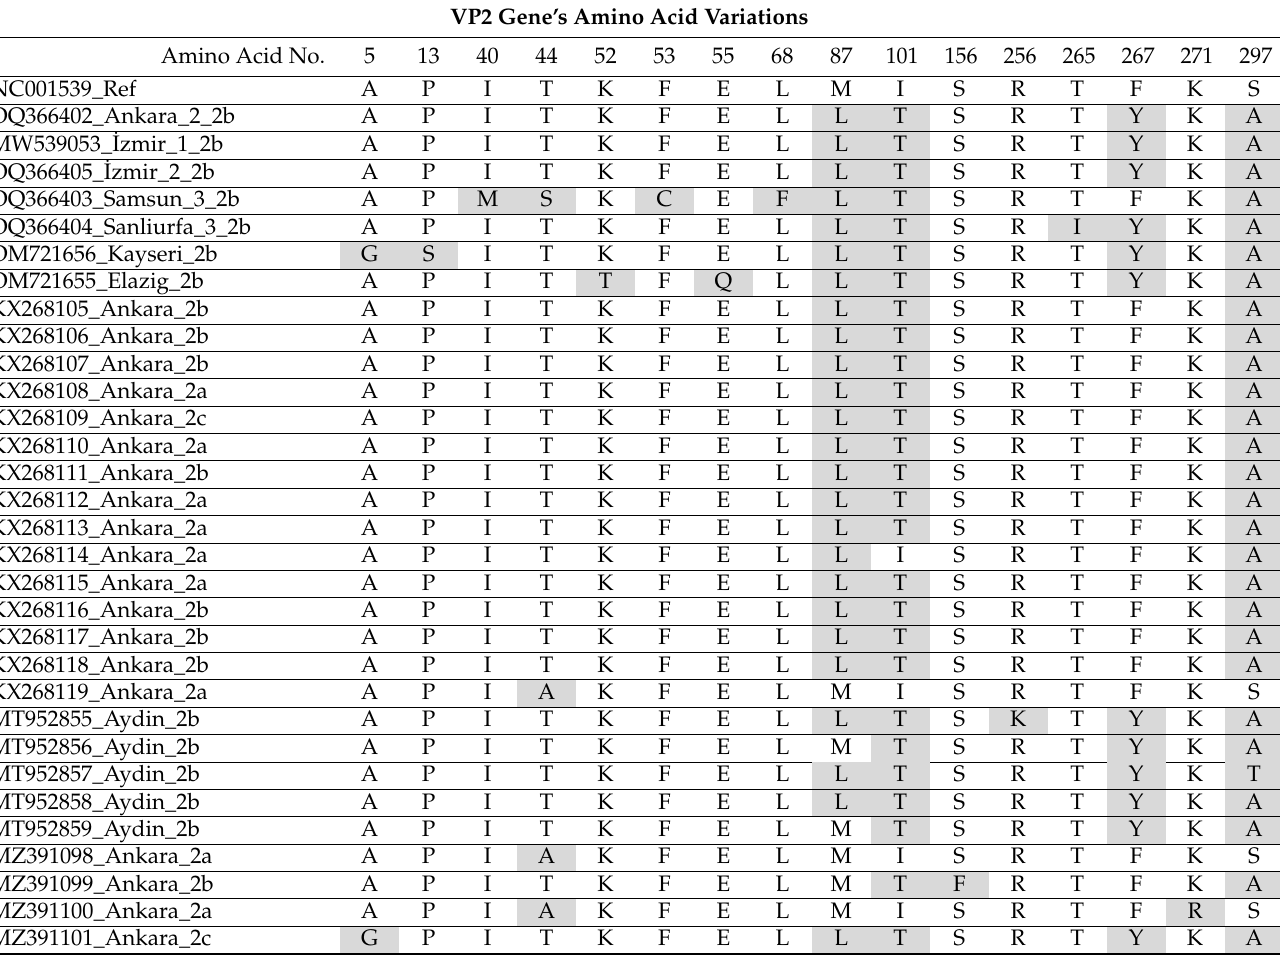
Table 1. VP2 gene’s amino acid variations. VP2 Gene’s Amino Acid Variations Amino Acid No.